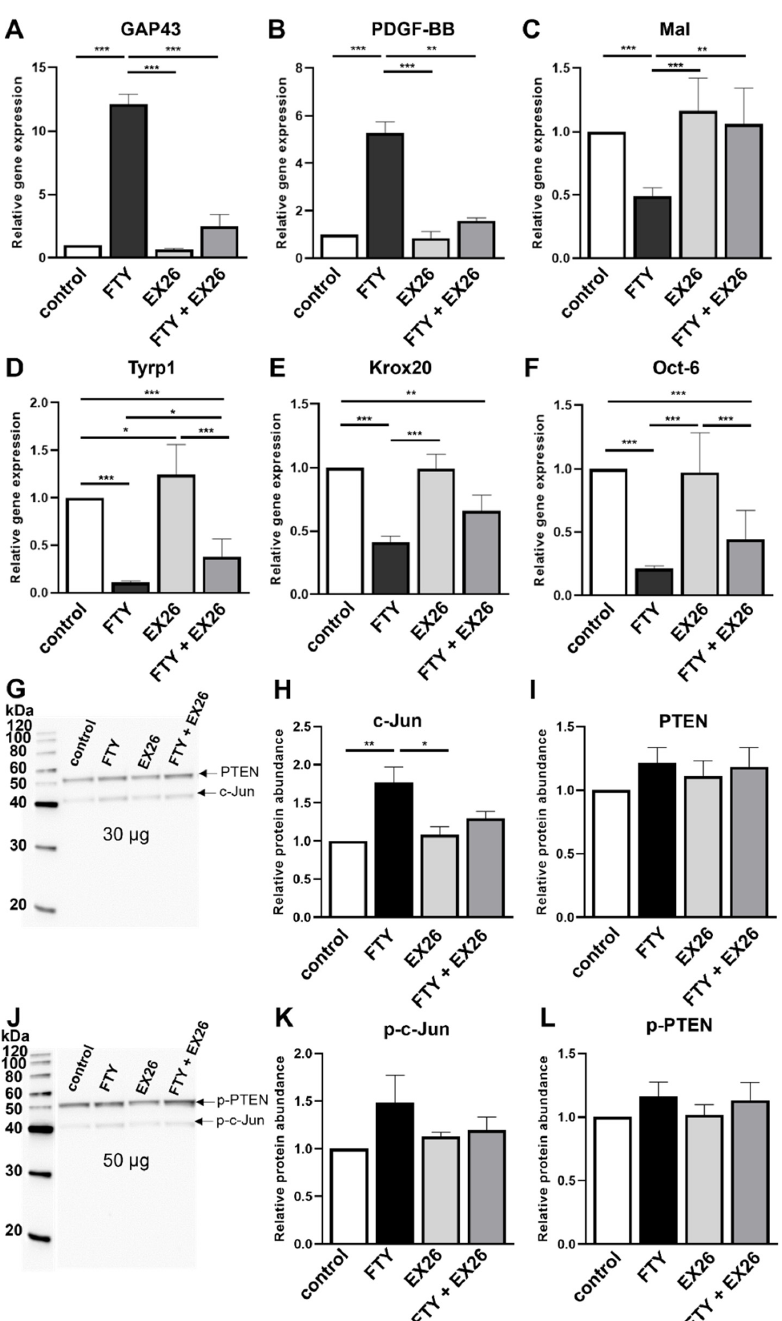
Figure 2. Antagonizing S1P1 reverses the effect of Fingolimod. Compared to Fingolimod (FTY) alone, the combination with the S1P1 antagonist EX26 abolished the transition to the repair phenotype. Upon combinatory treatment, GAP43 ( A ), PDGF-BB ( B ) and Mal ( C ) showed similar expression levels compared to control (buffer) treated SCs. Expression levels of Tyrp1 ( D ), Krox20 ( E ) and Oct-6 ( F ) slightly increased compared to Fingolimod. To exclude side effects of the antagonist, EX26 was applied alone revealing only a slight upregulation of Tyrp1 compared to control. For statistical analysis, a one-way ANOVA with Tukey’s multiple comparison test was used, * p < 0.05, ** p < 0.01, *** p < 0.001. Shown are the mean values ± SEM with at least n = 4 biological replicates. Western Blot analysis ( G , J ) and respective quantification revealed an induction of c-Jun ( H ) and p-c-Jun ( K ) after Fingolimod treatment for 24h which was abolished by co-application with the S1P1 antagonist EX26. No effect on PTEN ( I ) and p-PTEN ( L ) protein abundances was observed, respectively. Representative Western Blots are shown ( G , K ). Quantitative data include mean values ± SEM of three biological